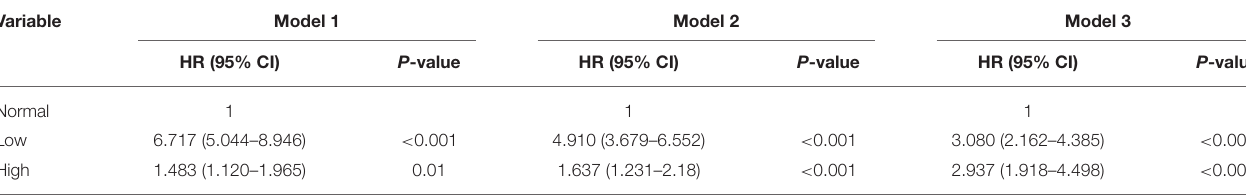
TABLE 3 | Cox regression analyses of the relationship between SBP and AMI prognosis.